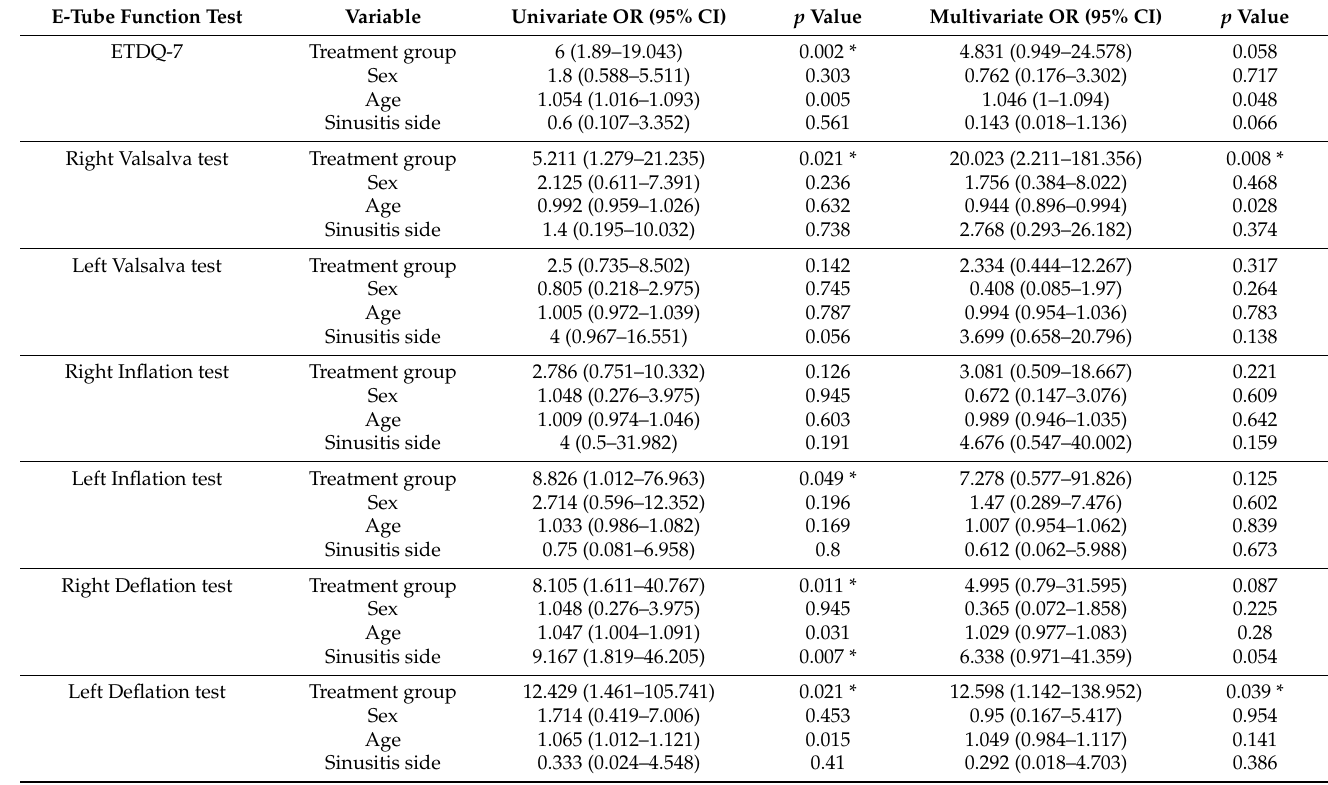
Table 5. Binary logistic regression analysis for factors influencing postoperative E-tube